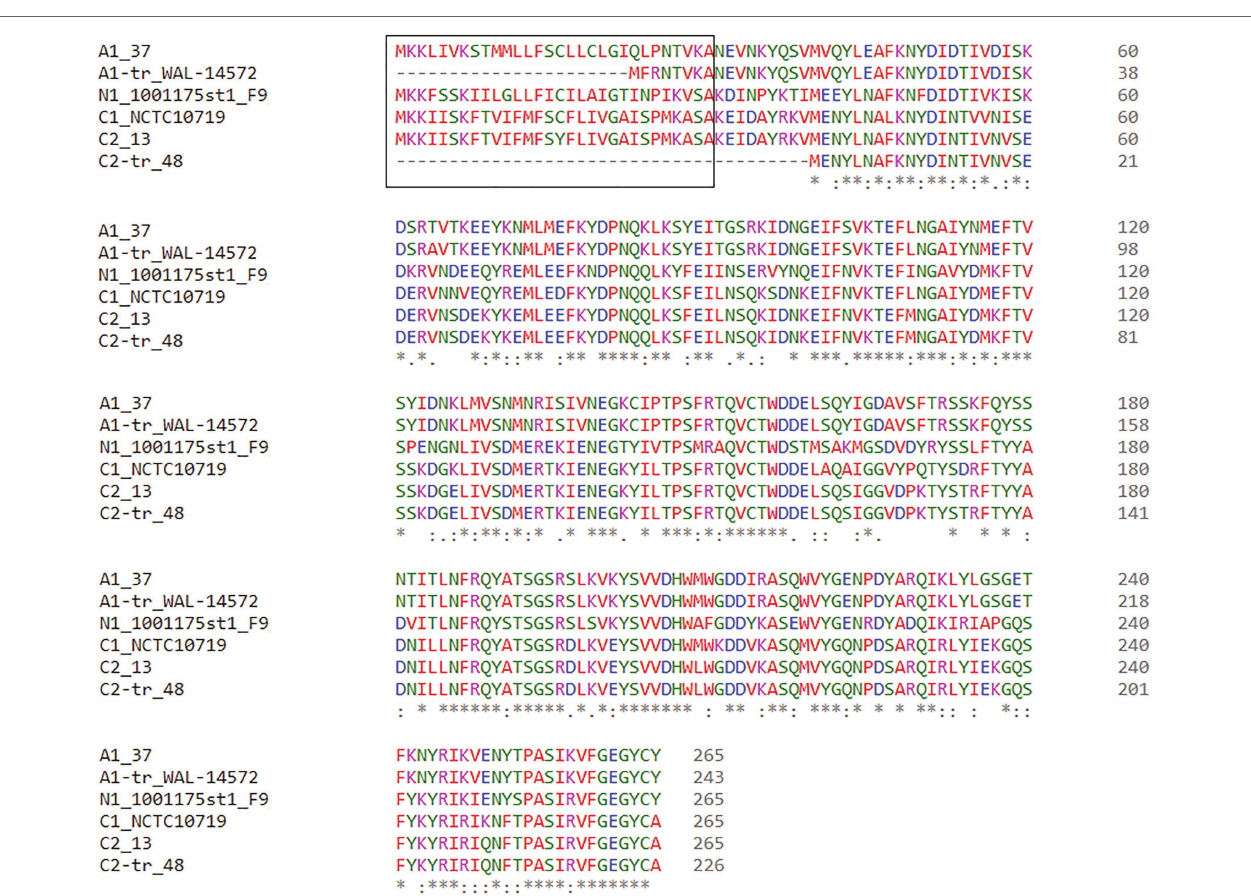
FIGURE 2 | Beta2 ( cpb2 ) toxin clustal alignment of each representative beta2 protein type. Amino acids are colored based on their physical properties: blue (acidic), red [small hydrophobic (includes aromatic except Y)], magenta (basic), and green [other (polar, Y)]. The signal peptide sequences are shown in the black